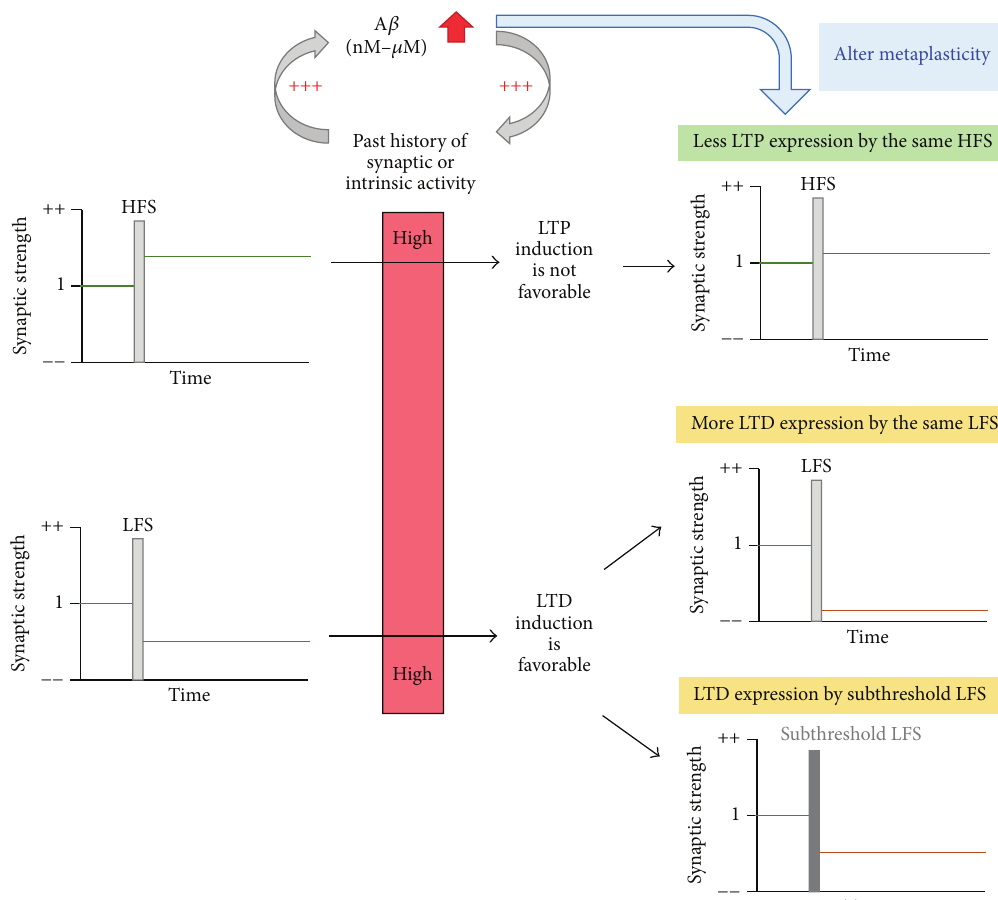
Figure 2: Aberrant metaplasticity in AD. A 𝛽 increases the activity of excitatory neurons, which in turn stimulates synthesis and release of A 𝛽 in a positive feedback loop, leading to pathologic accumulation of A 𝛽 . Neuronal hyperexcitability or early activation of GluN2B-containing NMDAR by heightened A 𝛽 expression induces aberrant metaplasticity, leading to inhibition of LTP by HFS and enhancement of LTD in the hippocampus by LFS or normal LTD induction by subthreshold